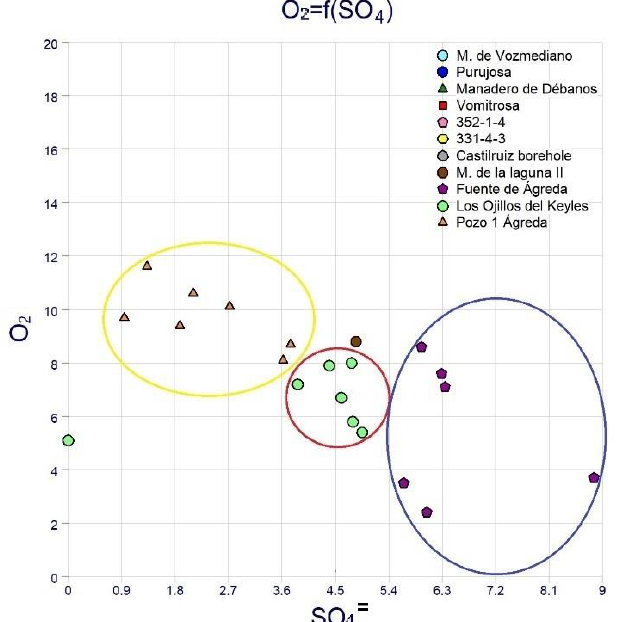
Figure 6. Oxygen/sulphate concentration binary diagram of a large part of the values in Table 1. Circles showing the grouping of these values according to the three-water point, and that there are changes when the water flows from one point to another. It is clear that the oxygen is being consumed in favour of the generation of sulphates from Á greda well 1 to sulphur source.